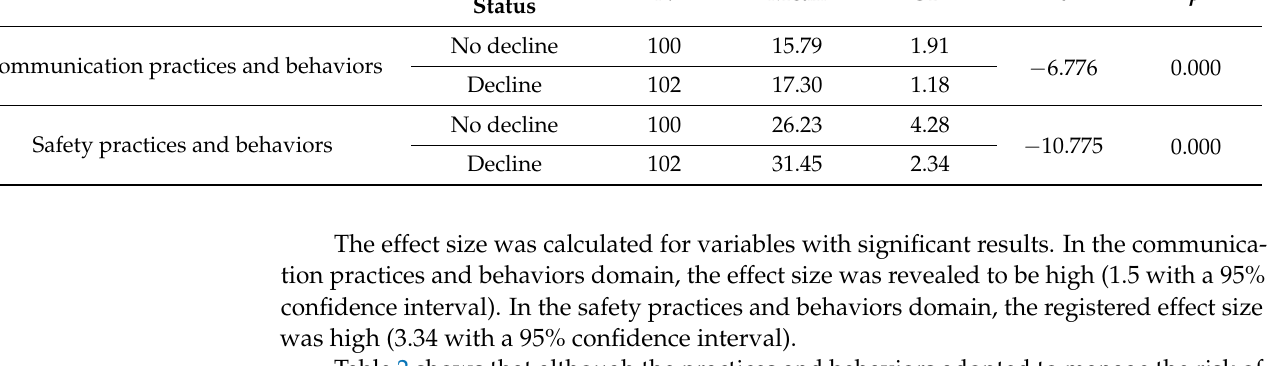
Table 1. Results of Student’s t -test relative to the practices and behaviors adopted by older adults to manage the risk of falls according to the cognitive status of older adults. Lisbon; 2020. Cognitive N Mean SD t p Status No decline 100 Communication practices and behaviors No Safety practices and behaviors